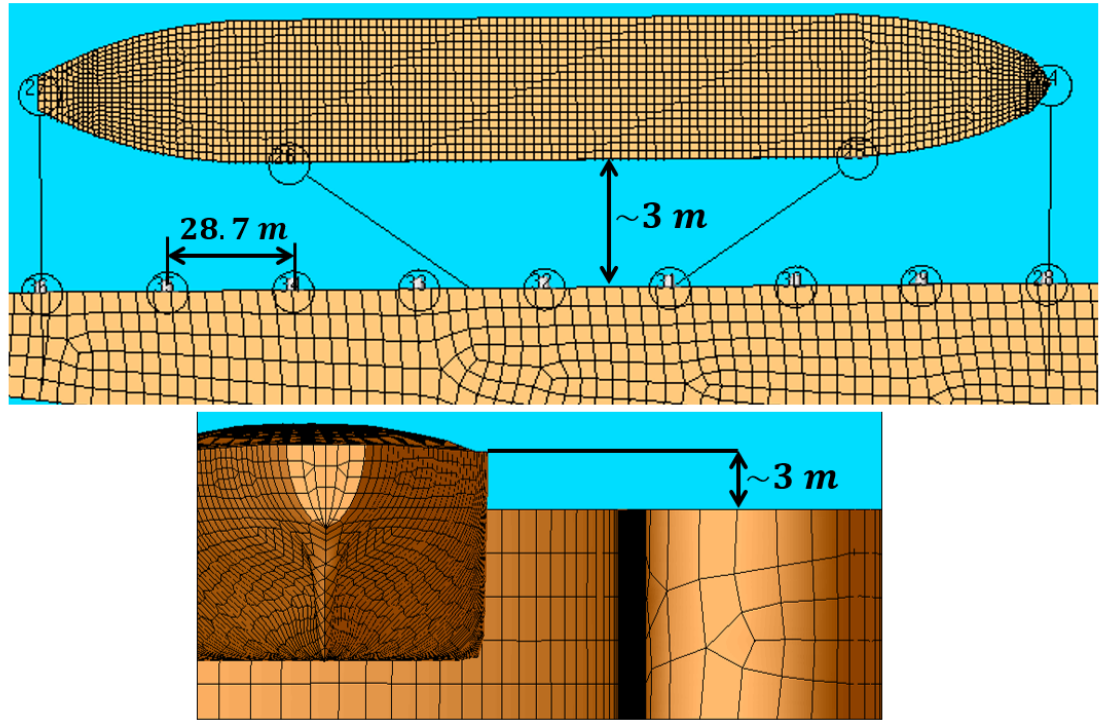
Figure 2. The berth mooring system layout. Top: view from above; bottom: view from the back. Note: the figures are slightly distorted for visual purposes.